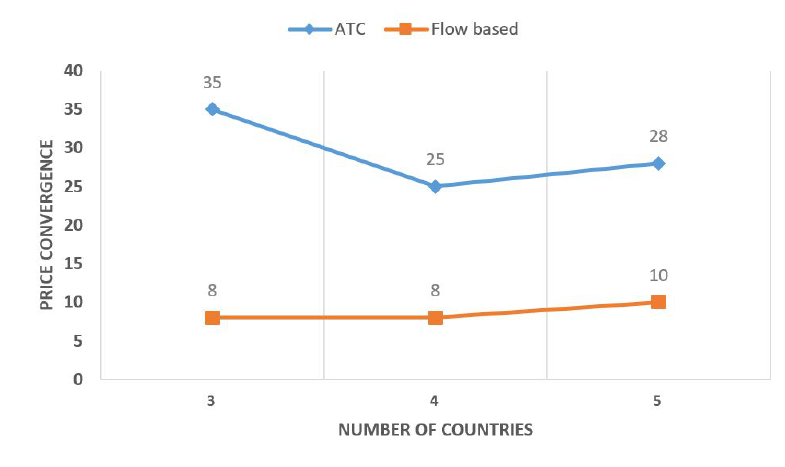
Figure 6. Price convergence index for different number of